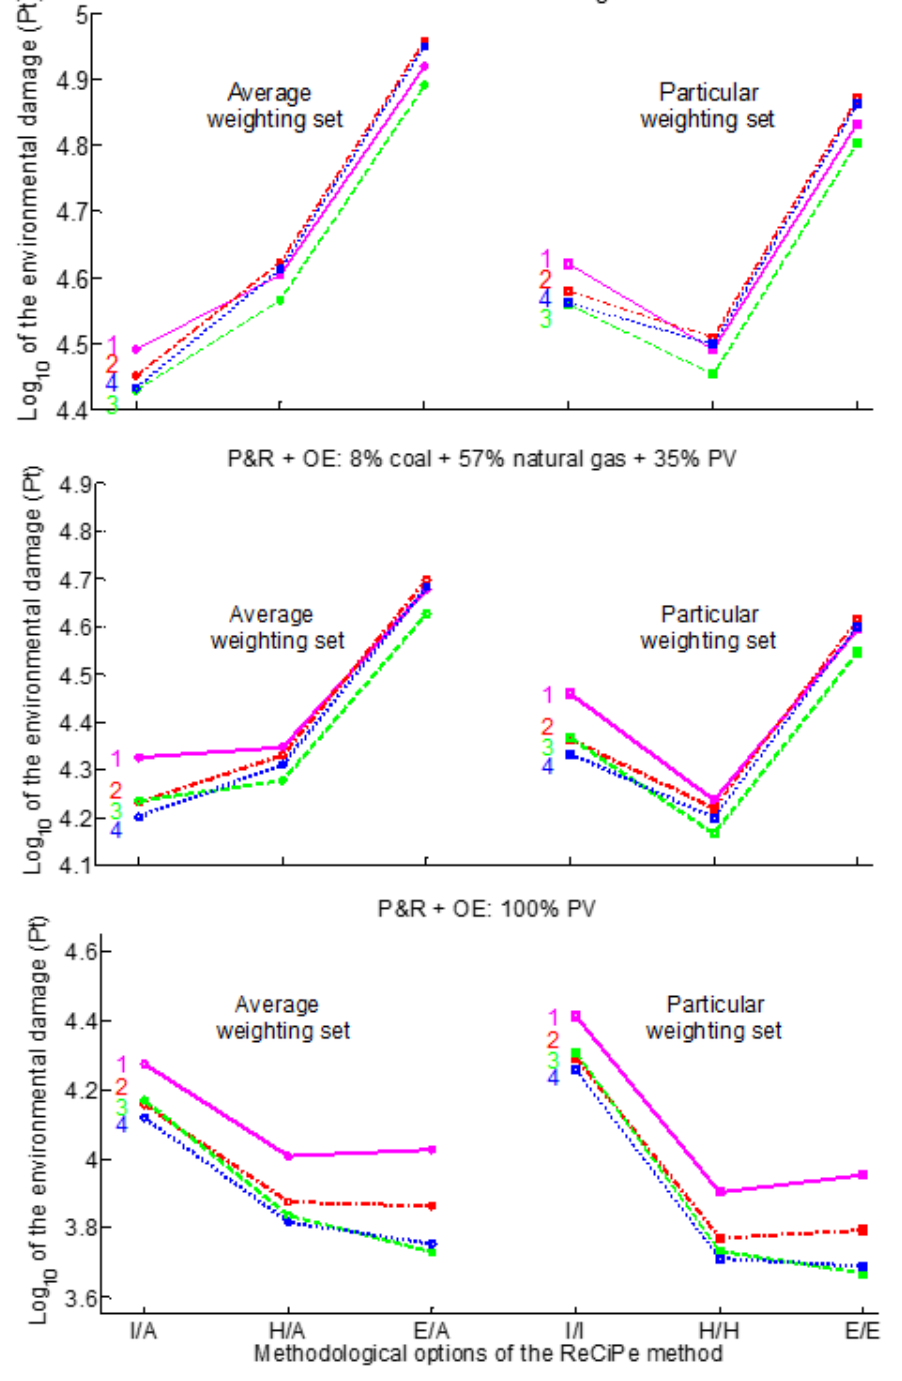
Figure 9. P&R + OE stages: environmental damage of CB MinWin (1), CB MaxWin (2), AAB MinWin (3), and AAB MaxWin (4), evaluated with ReCiPe2016 endpoint single-score method using individualist/average (I/A), hierarchist/average (H/A), egalitarian/average (E/A), individualist/individualist (I/I), hierarchist/hierarchist (H/H), and egalitarian/egalitarian (E/E).